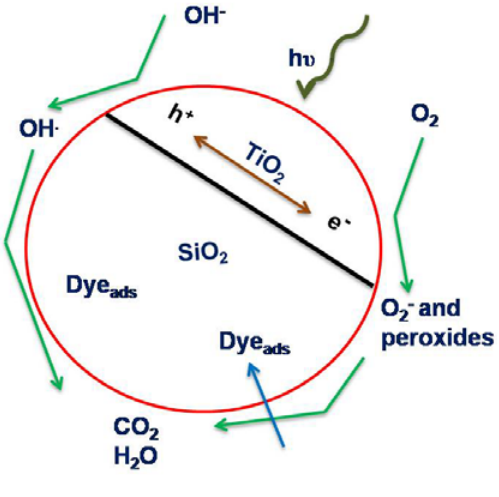
with the role of SiO 2 2